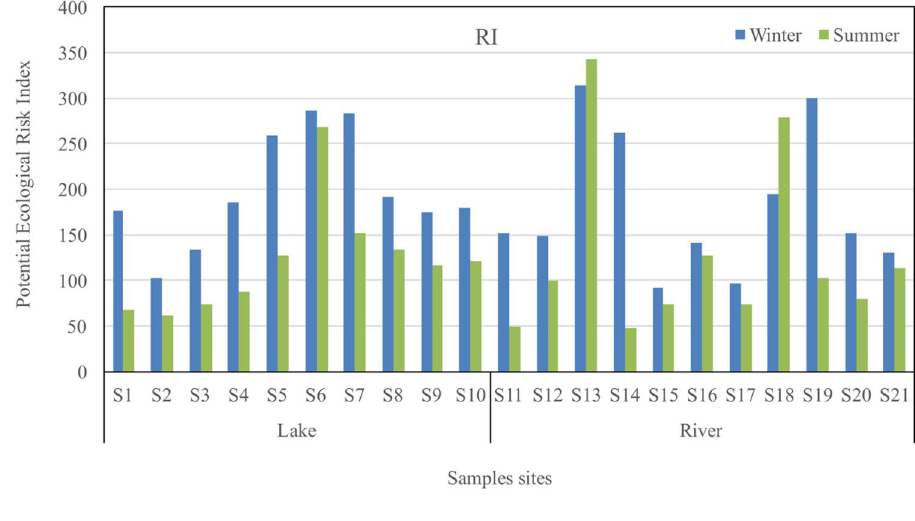
Fig. 7 Contributions of heavy metals to the sum of the toxic